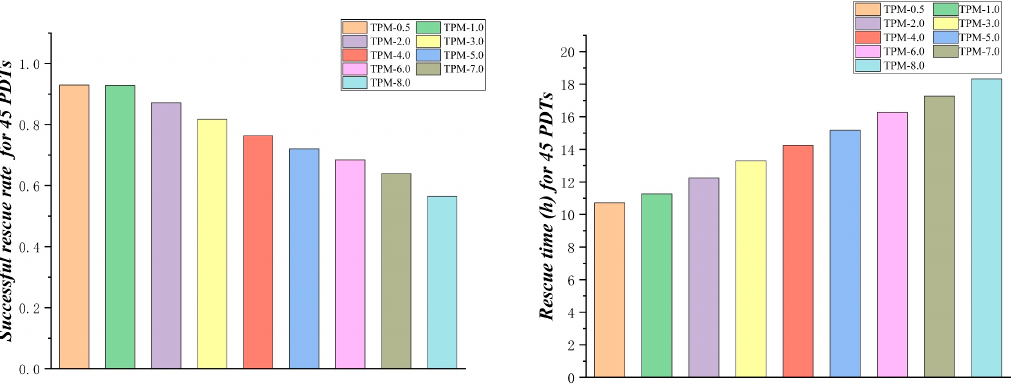
Figure 17. Successful rescue rate and rescue time for 45 PDTs with delay time from 0.5 h to 8.0 h.